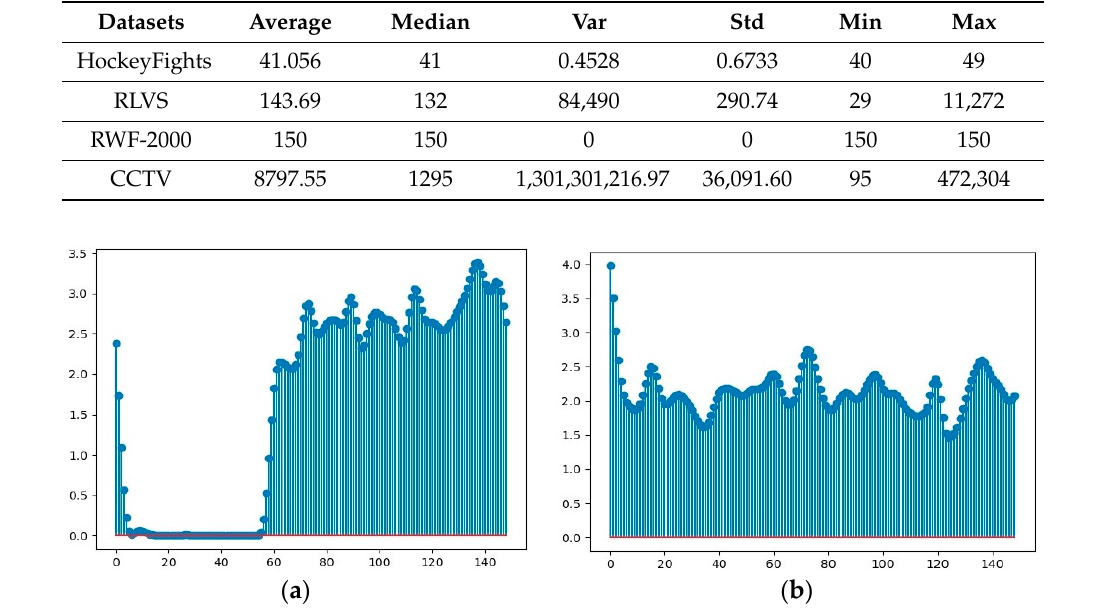
Figure 11. Frame differences for violent videos. ( a ) camera movement, ( b ) Camera fixation.